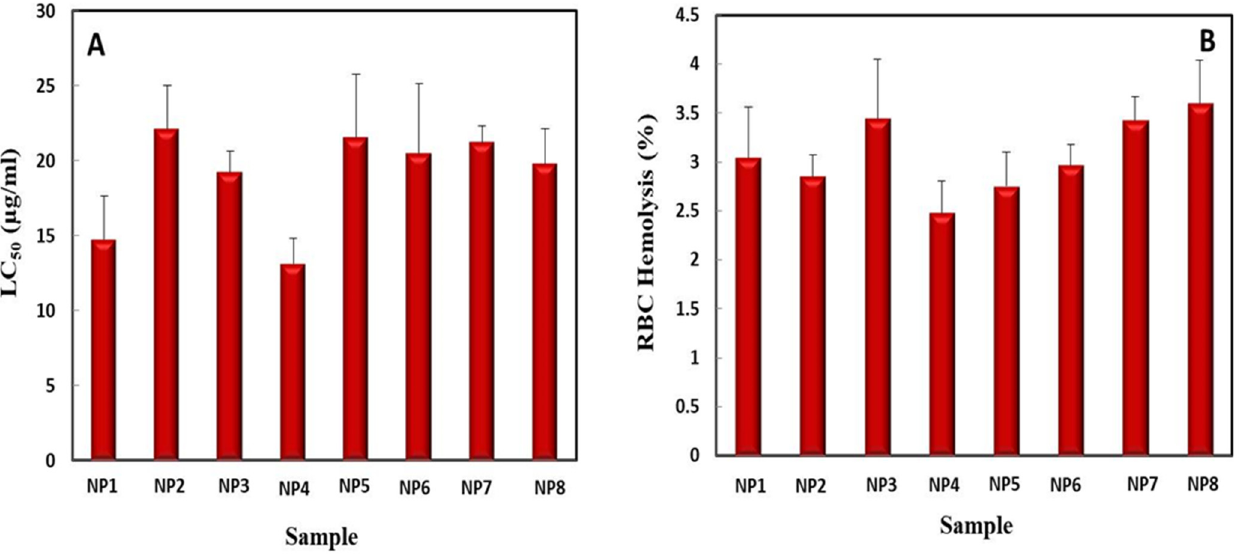
Figure 13. Biocompatibility studies of NPs. ( A ) Brine shrimp lethality assay of NPs. ( B ) Biocompatibility of NPs assessed with hRBCs. The data represent the mean of 3 replicates ± SE. (Note—NP1: control AgNPs; NP2: UV-C mediated AgNPs; NP3: control ZnONPs; NP4: UV-C mediated ZnONPs; NP5: control bimetallic Ag–ZnONPs (0.1/0.1); NP6: UV-C mediated bimetallic Ag–ZnONPs (0.1/0.1); NP7: control bimetallic Ag–ZnONPs (0.1/0.5); NP8: UV-C mediated bimetallic Ag–ZnONPs (0.1/0.5)).